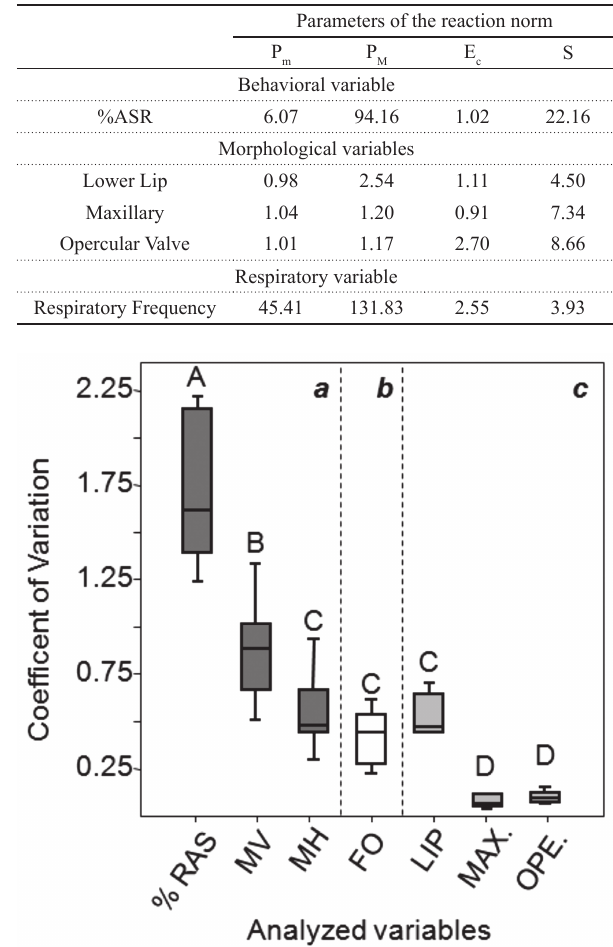
Table 1. Parameters of the logistic reaction norm describing the variation of morphological, behavioral and respiratory variables of Piaractus mesopotamicus respect to DO variation. P : Minimum phenotypic value; PM: Maximum m phenotypic value; E : Critical environmental value (DO c concentration) at the inflection point; S: slope at the inflection point and; %ASR: percentage of time performing ASR.